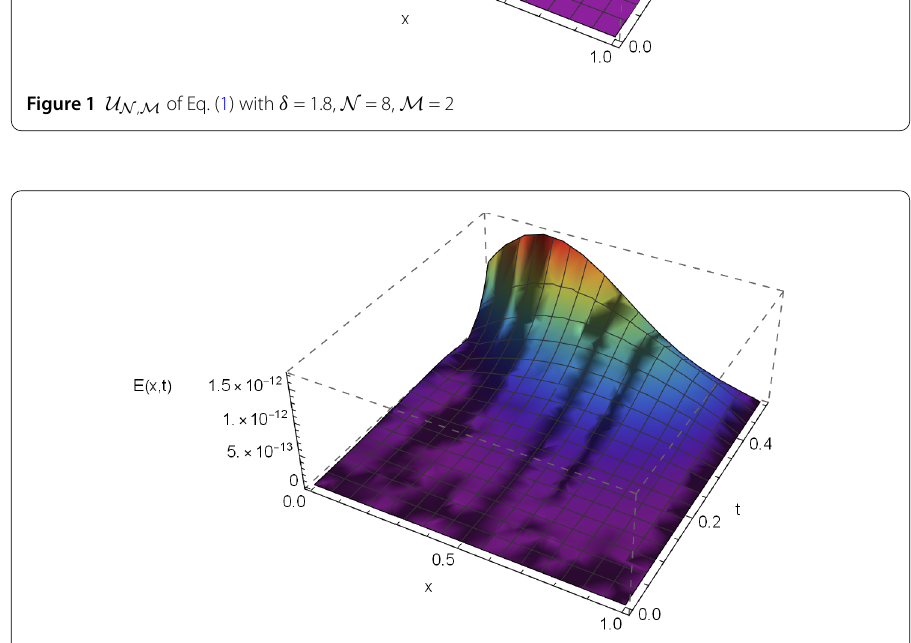
Figure 2 E ( x , t ) of Eq. (1) with δ = 1.8, N = 8, M = 2